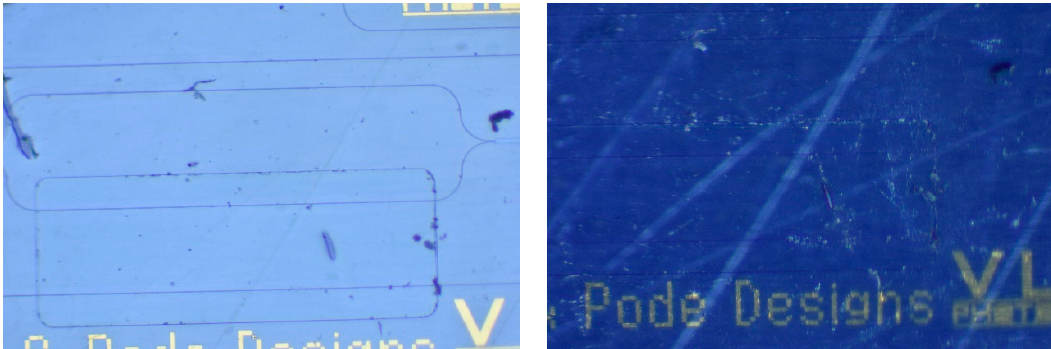
Figure 4. LC alignment as seen between crossed polarizers. The ( left ) image shows the clear state of the homogenous alignment with the sample aligned at 45° to the analyzer. In the ( right) image, the the homogenous alignment with the sample aligned at 45 ◦ to the analyzer. In the ( right ) image, the sample is aligned with only a slight angle (3°) to the analyzer. sample is aligned with only a slight angle (3 ◦ ) to the